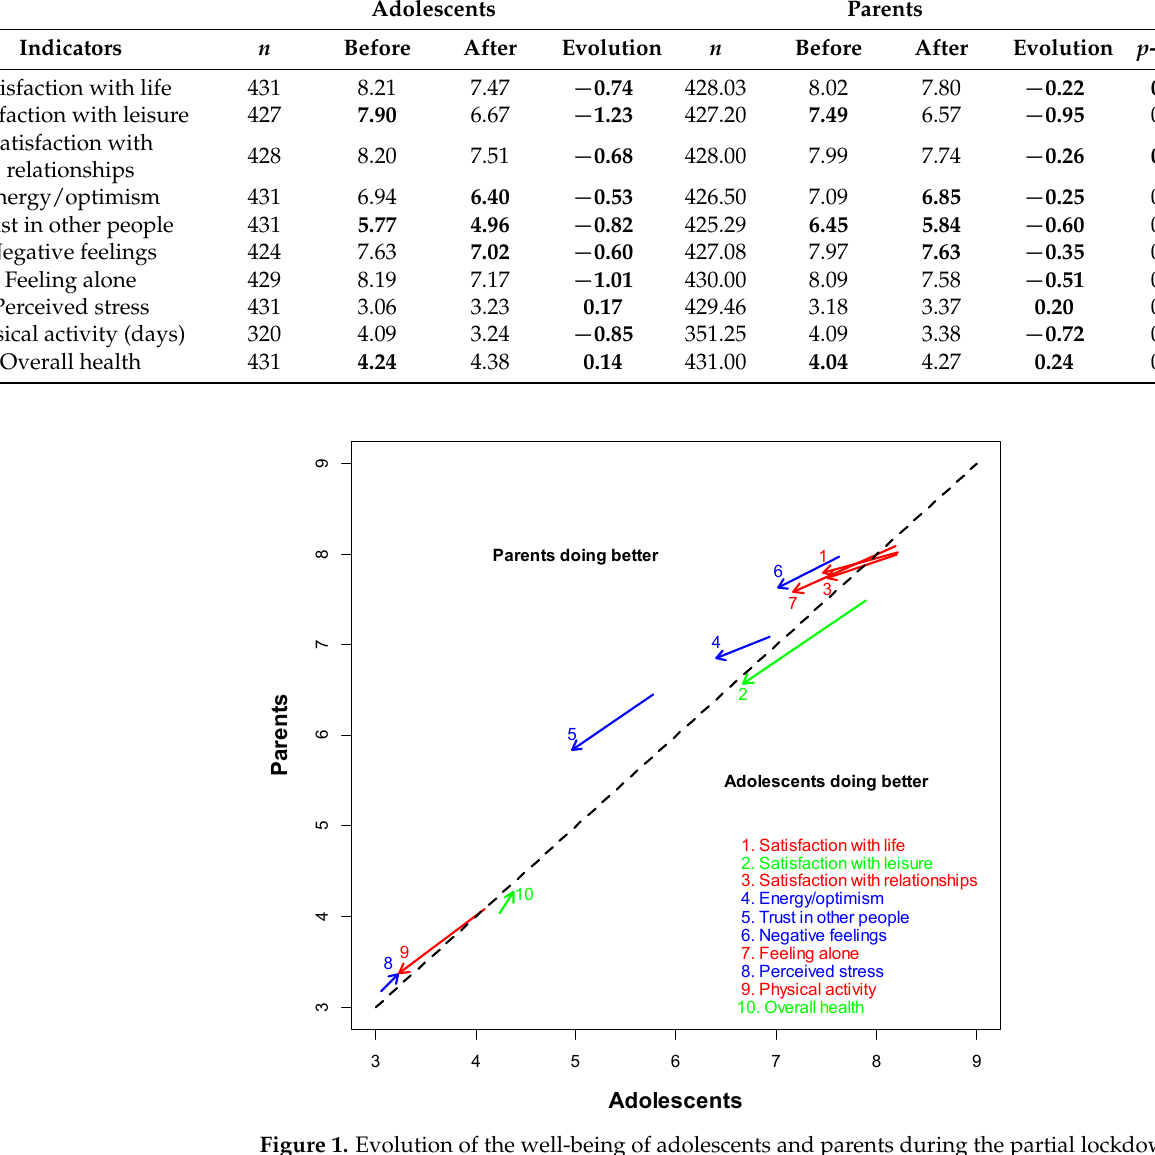
Figure 1. Evolution of the well-being of adolescents and parents during the partial lockdown. Globally, all indicators worsened during the partial lockdown period, the only two exceptions being the level of perceived stress and the overall health of both adolescents and their parents. All changes between the pre- and post-lockdown situations were statis- tically significant, but if we now compare the level of change observed in the adolescents with that of their parents, we can see that this level was statistically different for only two indicators: satisfaction with life, and satisfaction in relationships, with in both cases a greater deterioration in the adolescents. For the other eight indicators, the level of change observed in adolescents did not differ statistically from that of parents.